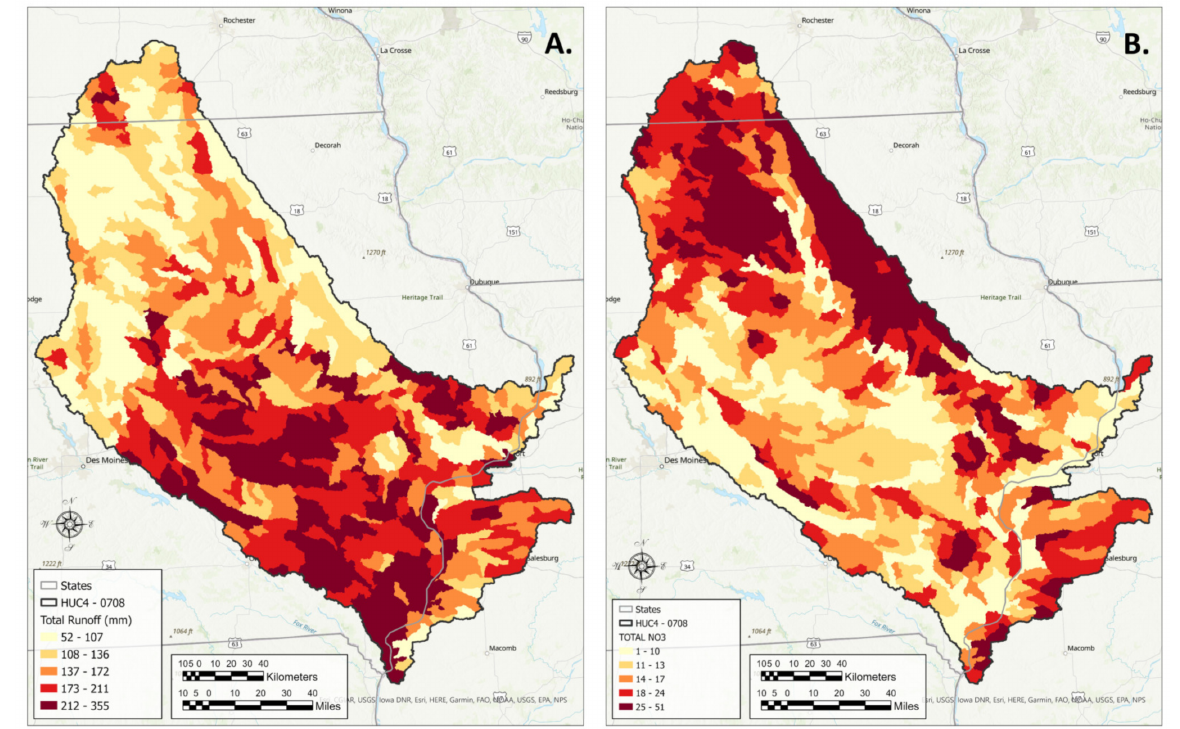
Figure 4. Mean annual surface runoff obtained from the NAM for HUC12 watersheds in the Iowa- Cedar basin ( A ), and mean annual NO 3 -N loss by HUC12 obtained from the NAM ( B